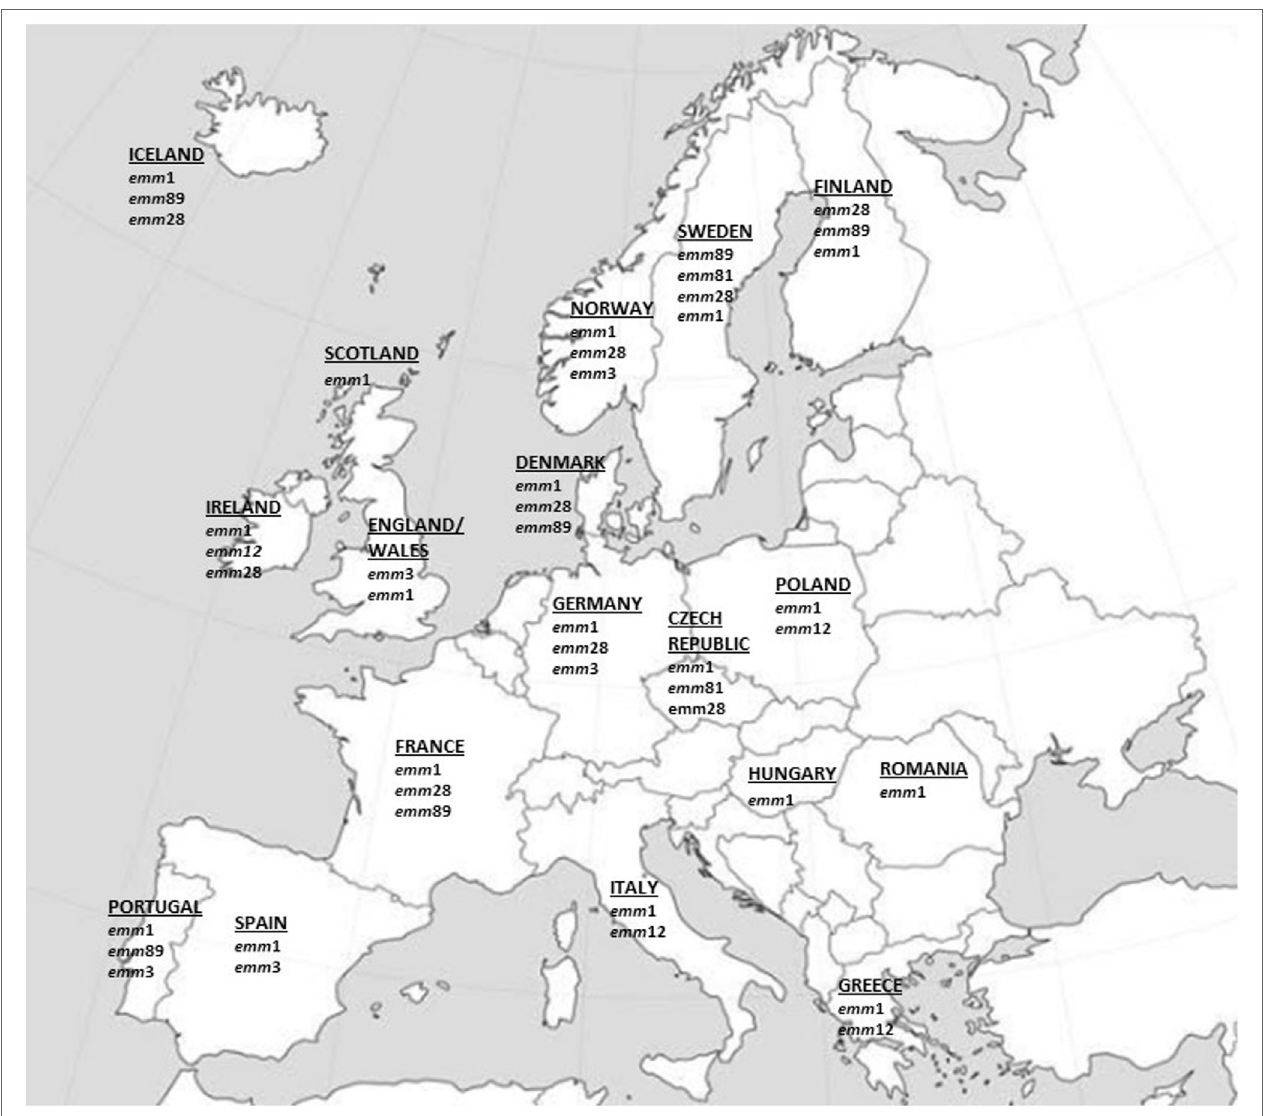
FiGURe 1 | Most prevalent invasive GAS emm types in Europe since 2000 onward. The major emm types (accounting for approximately ≥ 10% of all emm types) from European epidemiologic surveys that met the criteria used in this review are